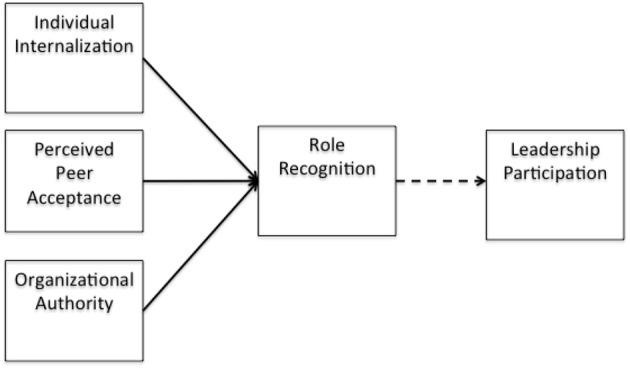
Role recognition.